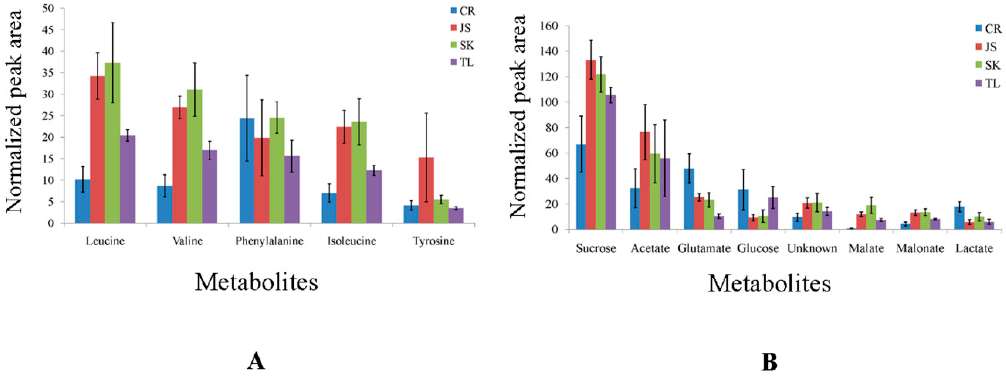
Figure 6. ( A ) Relative concentrations of discriminating amino acid metabolites (in terms of normalized peak areas) captured by OPLS-DA models derived from the 13 C-NMR spectra of Chinese red cooking, Japanese shoyu, Singapore Kikkoman and Taiwan super light soy sauce; ( B ) Relative concentrations (in terms of normalized peak areas) of significantly-different metabolites (excluding amino acids) captured by OPLS-DA models derived from the 13 C-NMR spectra of Chinese red cooking, Japanese shoyu, Singapore Kikkoman and Taiwan super light soy sauce.